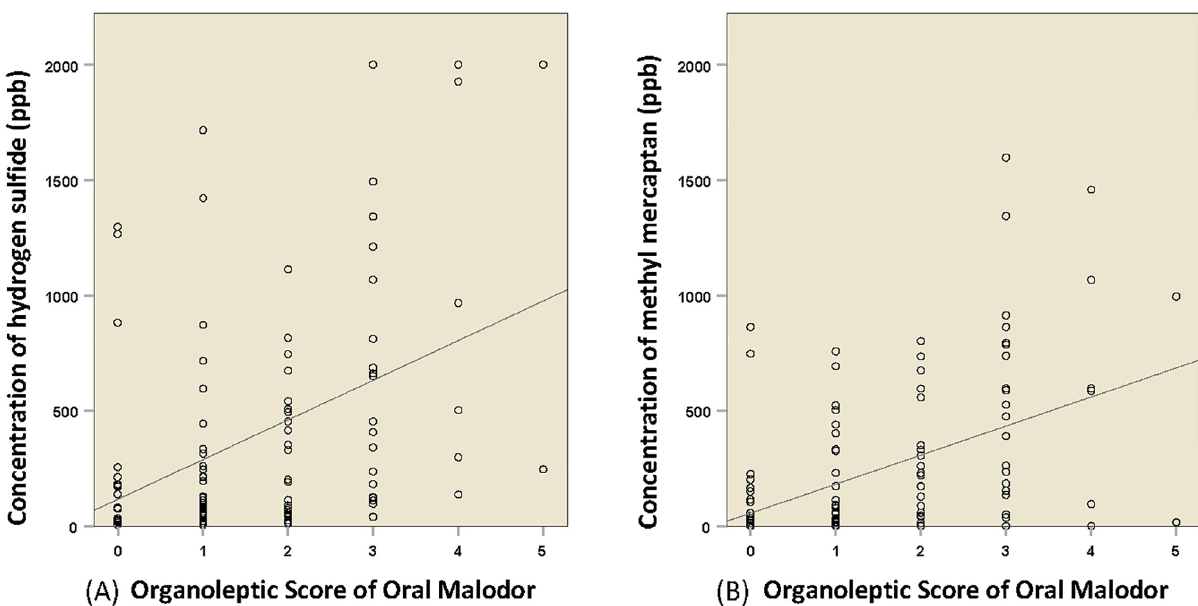
Fig 1. Correlation between organoleptic score (OLS) for oral malodor and the concentrations of volatile sulfur compounds (VSC) ( n = 111). (A) correlation between OLS and hydrogen sulfide level (ppb) in mouth air (Spearman’s ρ = 0.386, P < 0.001; partial r � = 0.401, P < 0.001); (B) correlation between OLS and methyl mercaptan level (ppb) in mouth air (Spearman’s ρ = 0.385, P < 0.001; partial r � = 0.392, P < 0.001). � Adjusted for age, sex, education level, tooth-brushing frequency, denture-wearing, periodontitis, hyposalivation, tongue coating, preference for onion, drinking, smoking, obesity, diabetes, hypertension, ear-nose-throat diseases and gastrointestinal diseases. Solid line represents the linear relationship of the correlation.